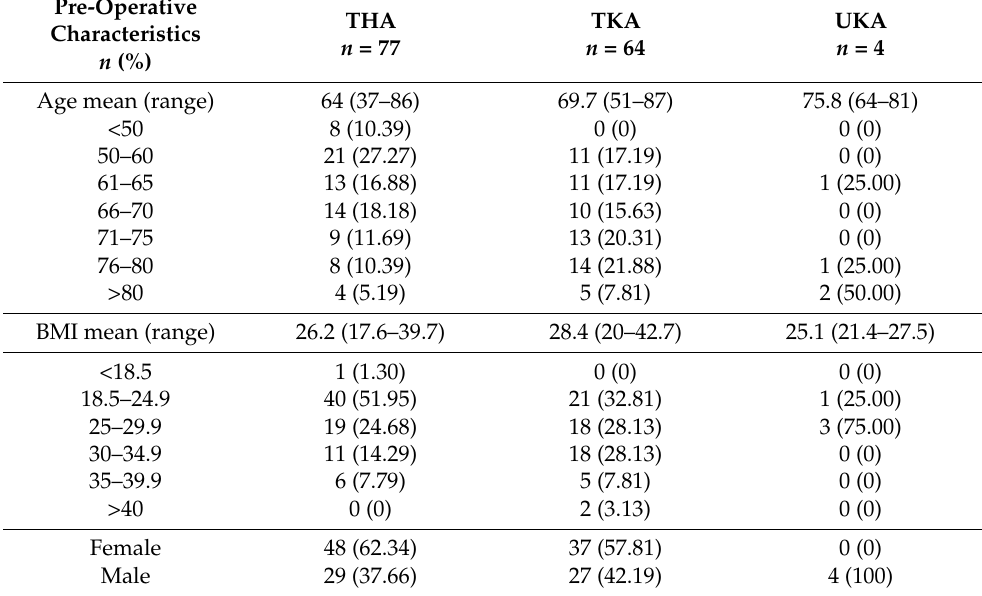
Table 2. Characteristics of patients that received a staged arthroplasty.